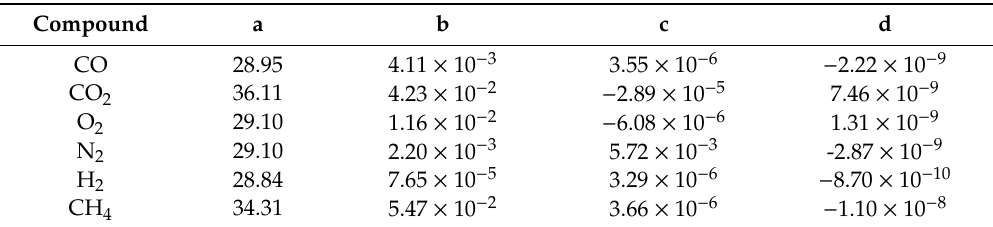
Table 6. Thermodynamic values (a,b,c,d) expressed in J · mol − 1 ◦ C − 1 , of gas components, for application in equation 10